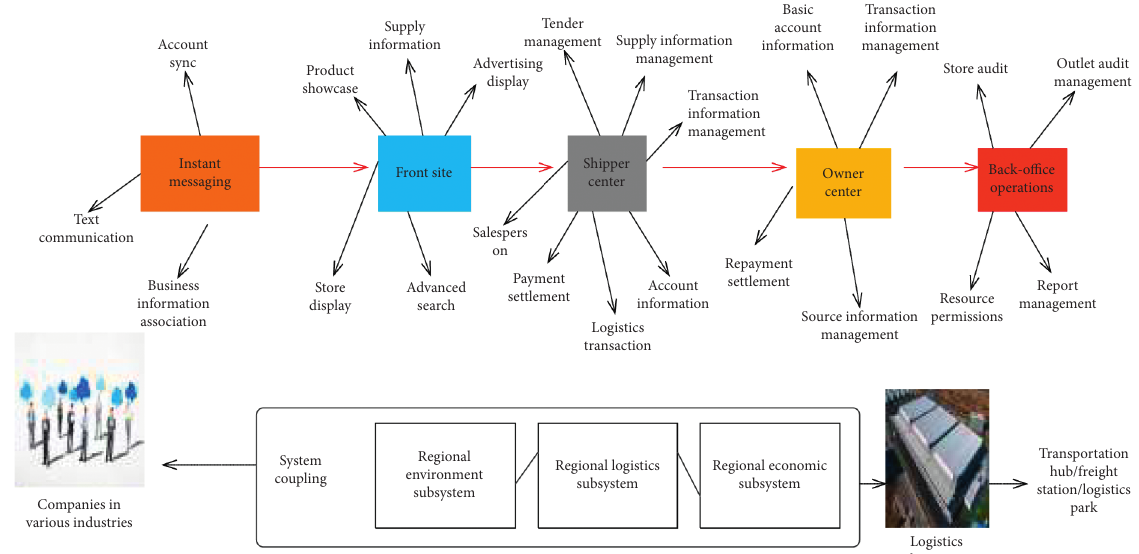
Figure 1: Regional logistics-economic-environmental system